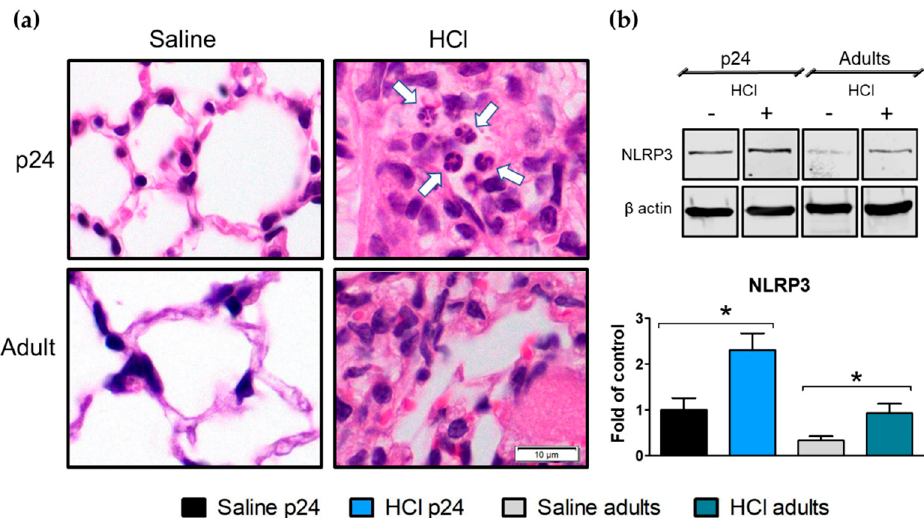
Figure 2. Histological evidence of inflammation and age-dependent activation of NLRP3 inflammasome, 30 days after HCl instillation. ( a ) Hematoxylin and Eosin staining revealed edema; increased alveolar thickness; mononuclear cell infiltration; and, in young HCl-instilled mice, neutrophil infiltration (white arrows). ( b ) Expression of the inflammasome NLRP3 increased in young and in adult mice instilled with HCl. Histograms represent the quantification of the blots. Original magnification 100 × , scale bars 10 µ M. Means ± SEM, n = 3, * p < 0.05; with one-way ANOVA and Tukey’s